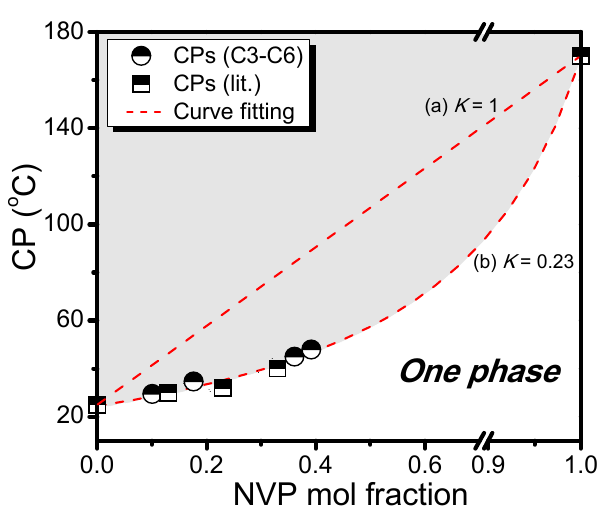
Figure 7. Experimental and theoretical plots of cloud points (CPs) vs. NVP molar fractions in the P(C 2 NVP- co -NVP) copolymers.